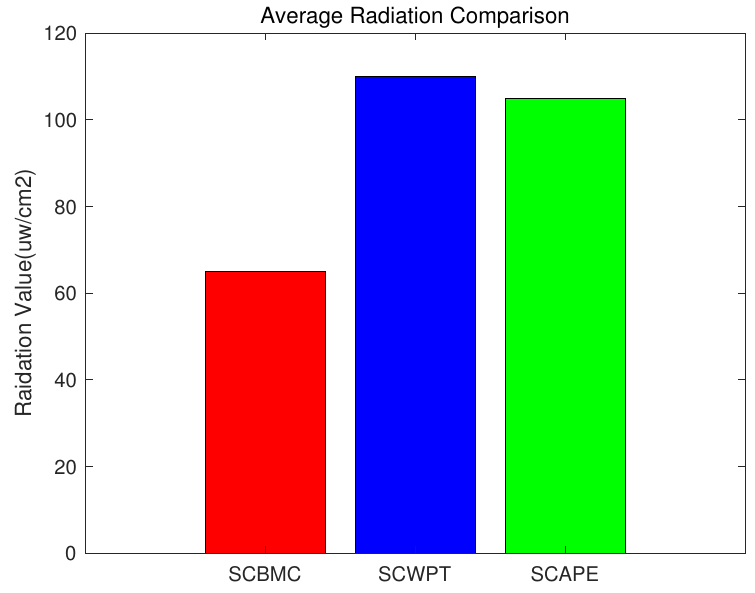
Figure 24. Comparison between Safe Charging Based on Multiple Mobile Chargers algorithm (SCBMC), Safe Charging for Wireless Power Transfer algorithm (SCWPT) and Safe Charging with Adjustable PowEr algorithm (SCAPE) about average